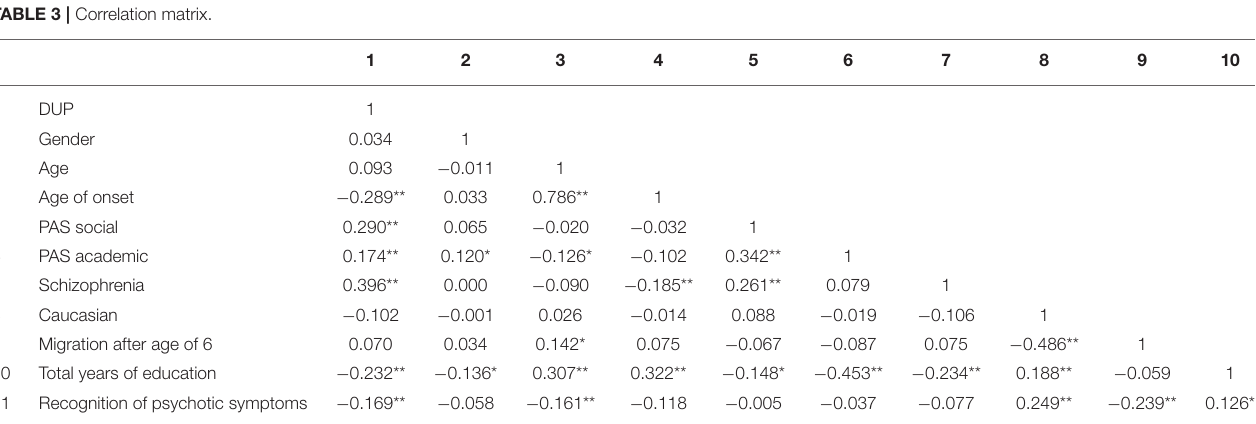
TABLE 3 | Correlation